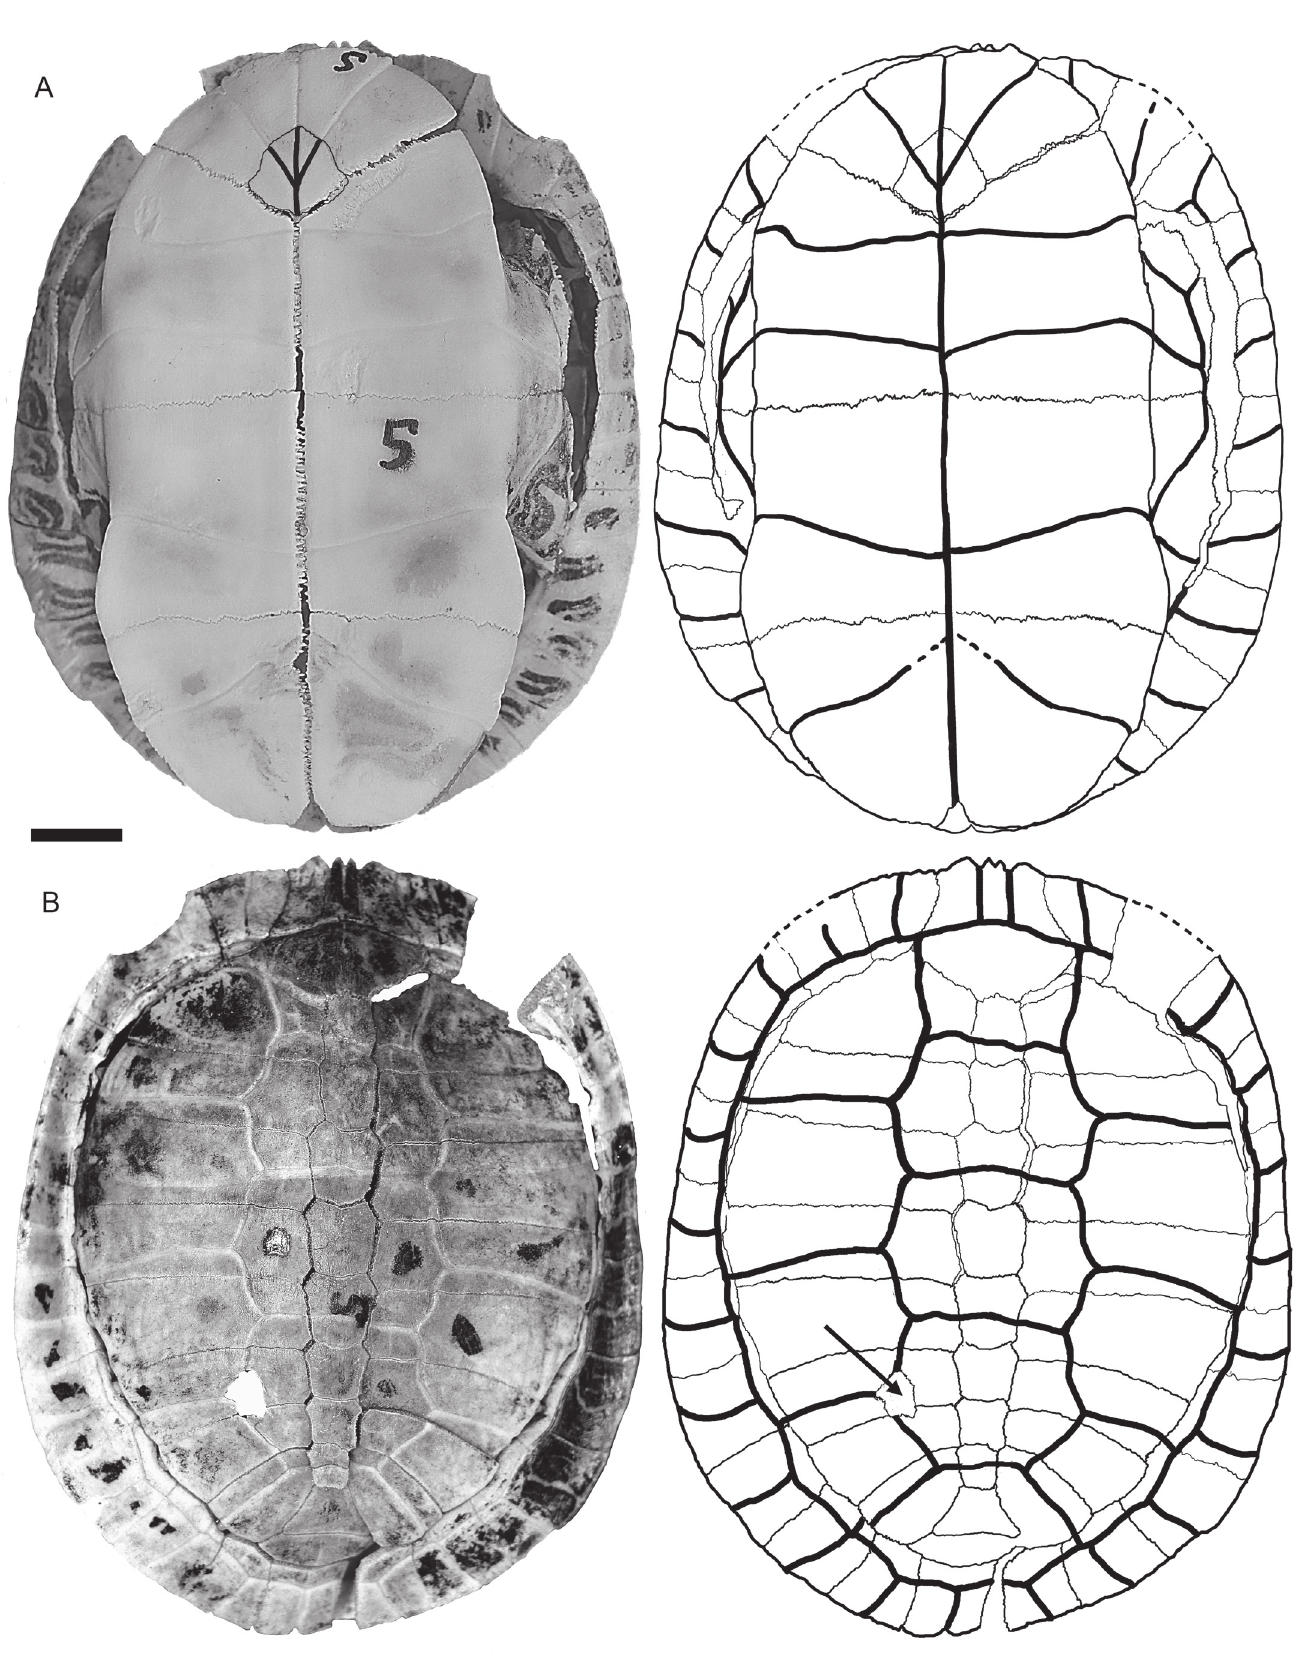
Figure 3. Chrysemys picta bellii, Neb 5. A, plastron and B, carapace. Arrow indicates missing region of bone. Dashed lines indicate indeterminate scute imprint, suture, or border due to damaged or missing bone. Scale bar = 1